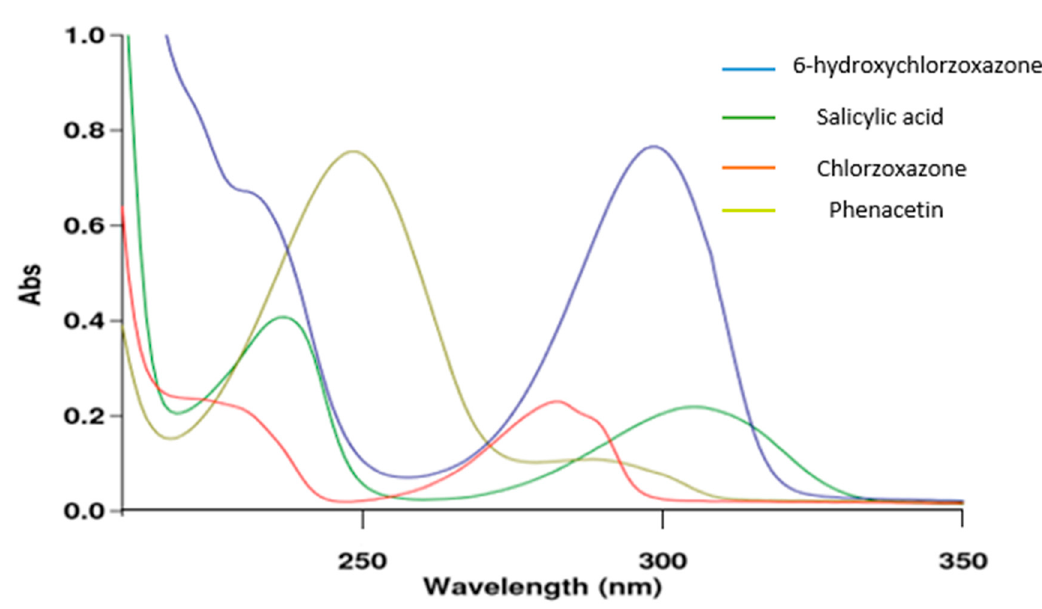
Figure 2. Overlain spectra of each component in the cytochrome P2E1 (CYP2E1) assay.